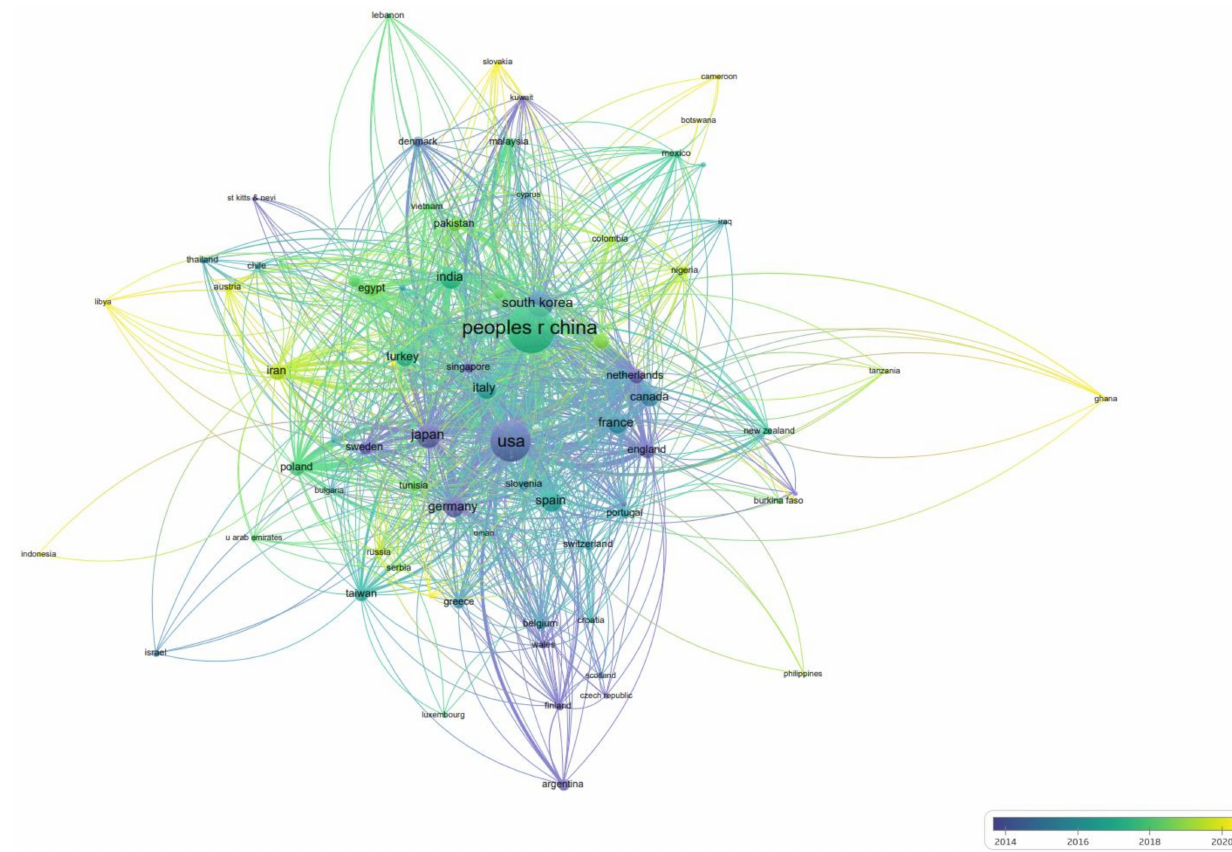
Figure 4. Country distribution of “BPA toxicity” literature according to citation